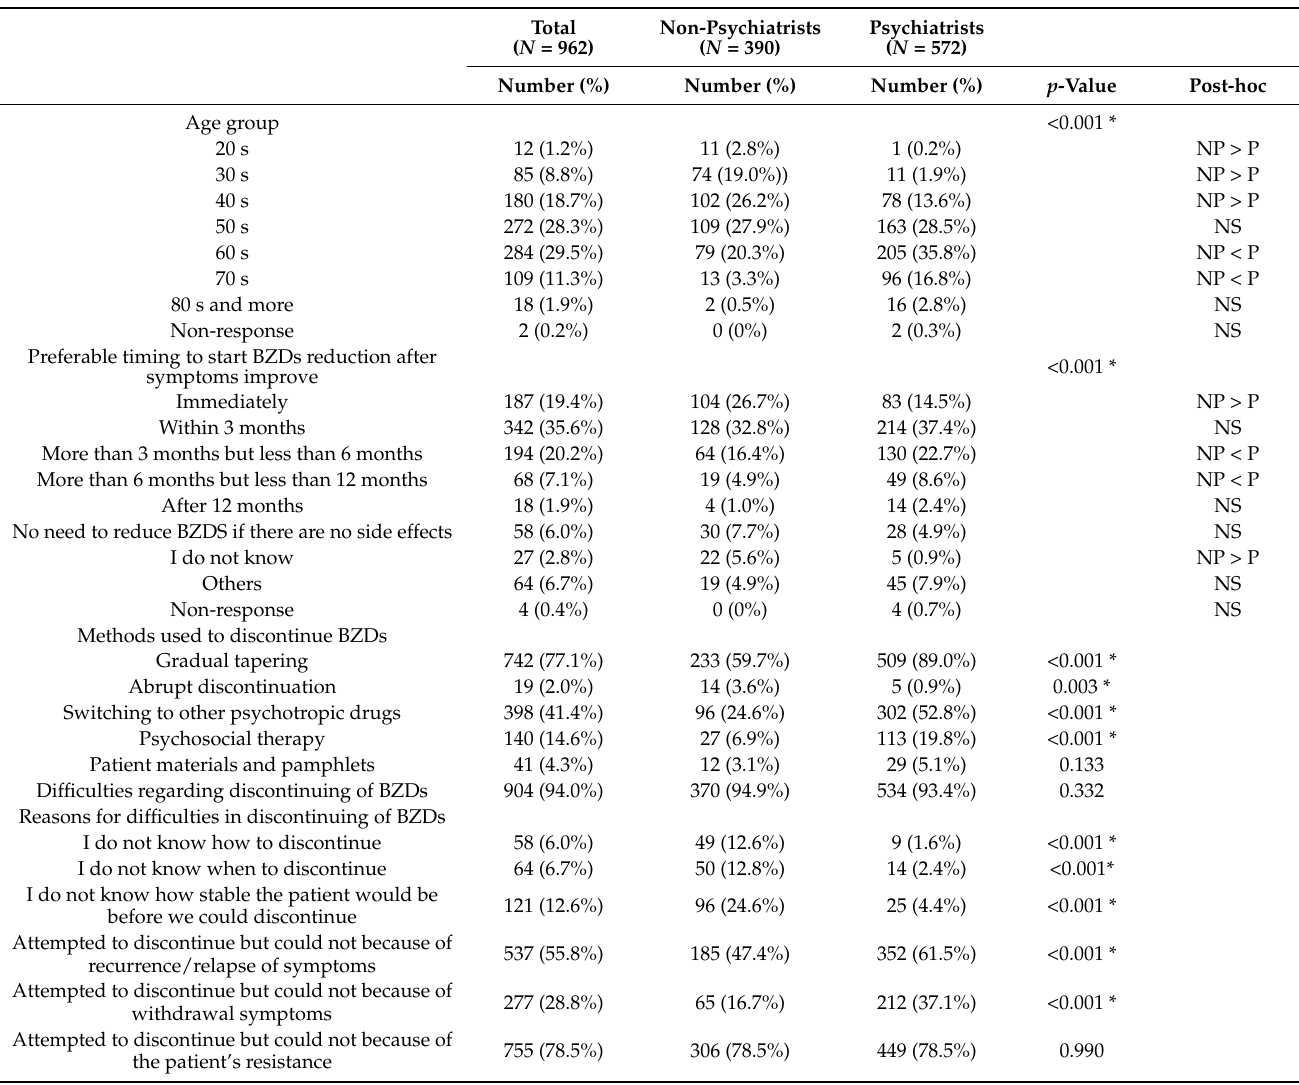
Table 1. Demographics of the